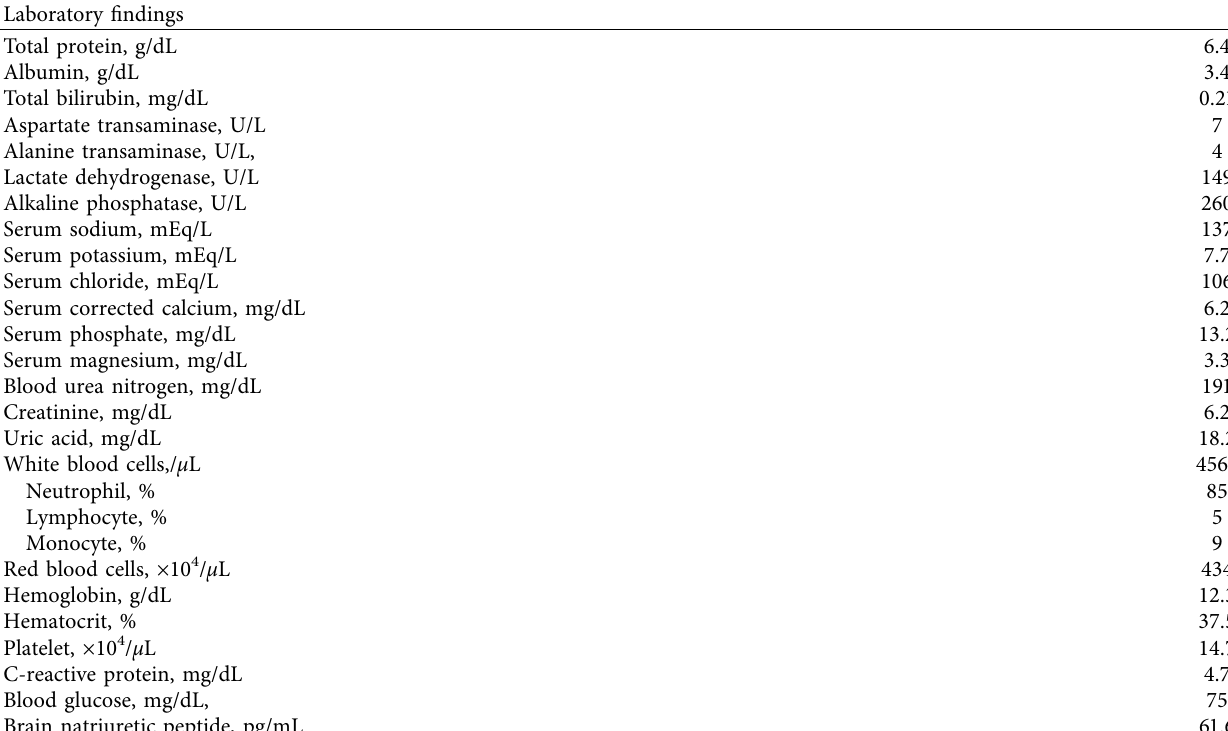
Table 1: Laboratory findings on admission.